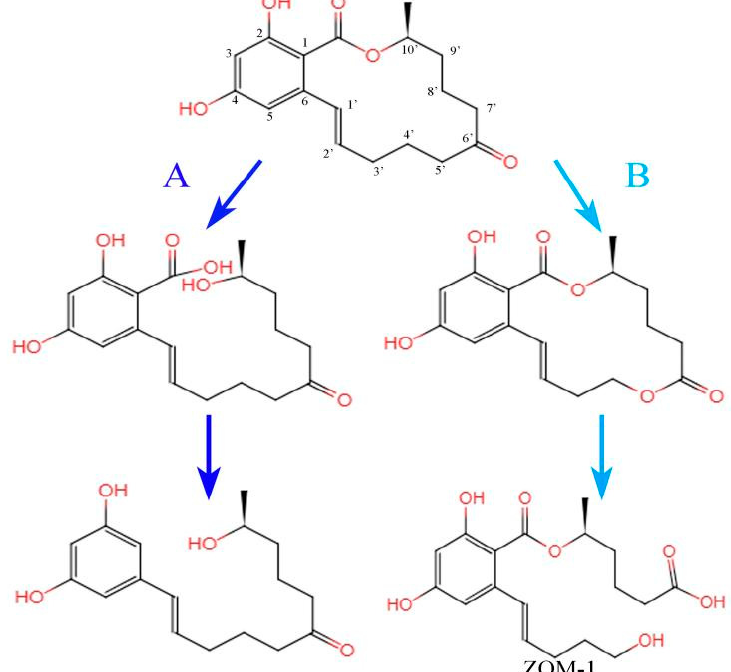
Figure 2. Biotransformation diagrams for zearalenone. ( A ) The hydrolysis of lactone ring. Final product: 1-(3,5-dihydroxyphenyl)-6’-hydroxy-l’-undecen-l0’-one. ( B ) The cracking of ketone carbonyl group. ZOM-1: (5S)-5-({2,4-dihydroxy-6-[(1E)-5-hydroxypent-1-en-1-yl]benzoyl}oxy)hexanoic acid.